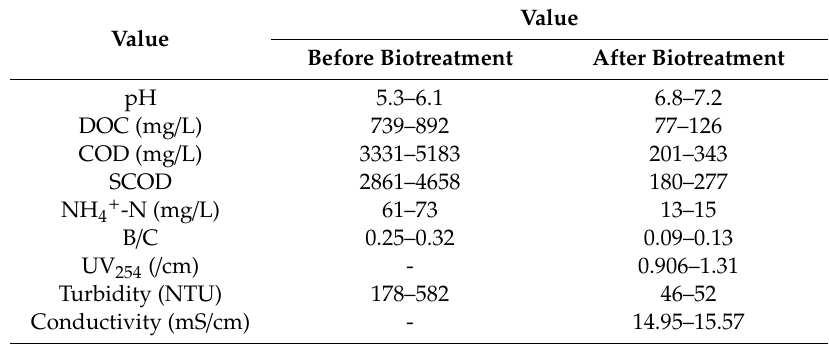
Table 1. Characteristics of the pharmaceutical wastewater before and after